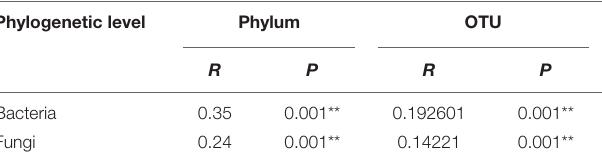
TABLE 1 | Analysis of similarity (ANOSIM) of the difference at Phylum and OUT among samples associated with Gossypium